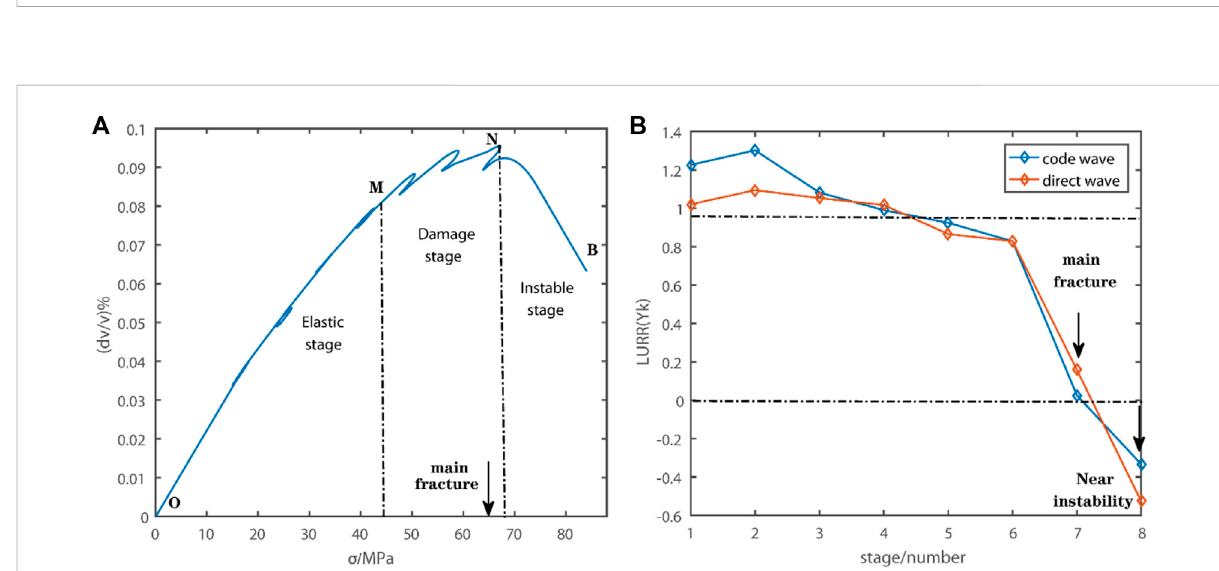
FIGURE 12 Relationship between relative wave velocity change and stress (A) and LURR of direct wave and coda wave (B)